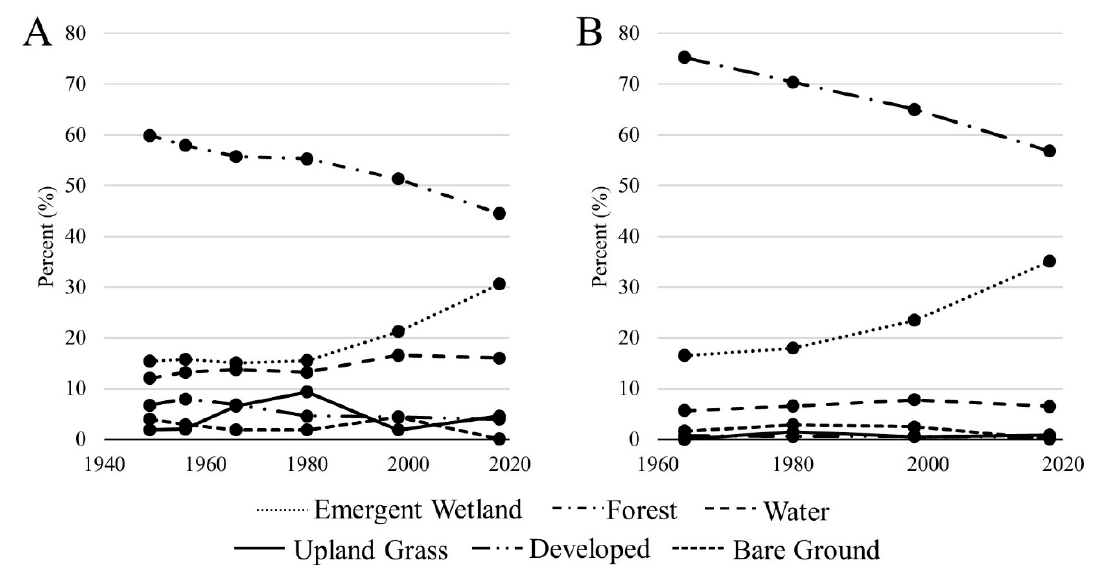
Figure 5. Percent land cover type (emergent wetland, forest, water, upland grass, developed, and bare ground) through time for ( A ) Smith Creek and ( B ) Town Creek.